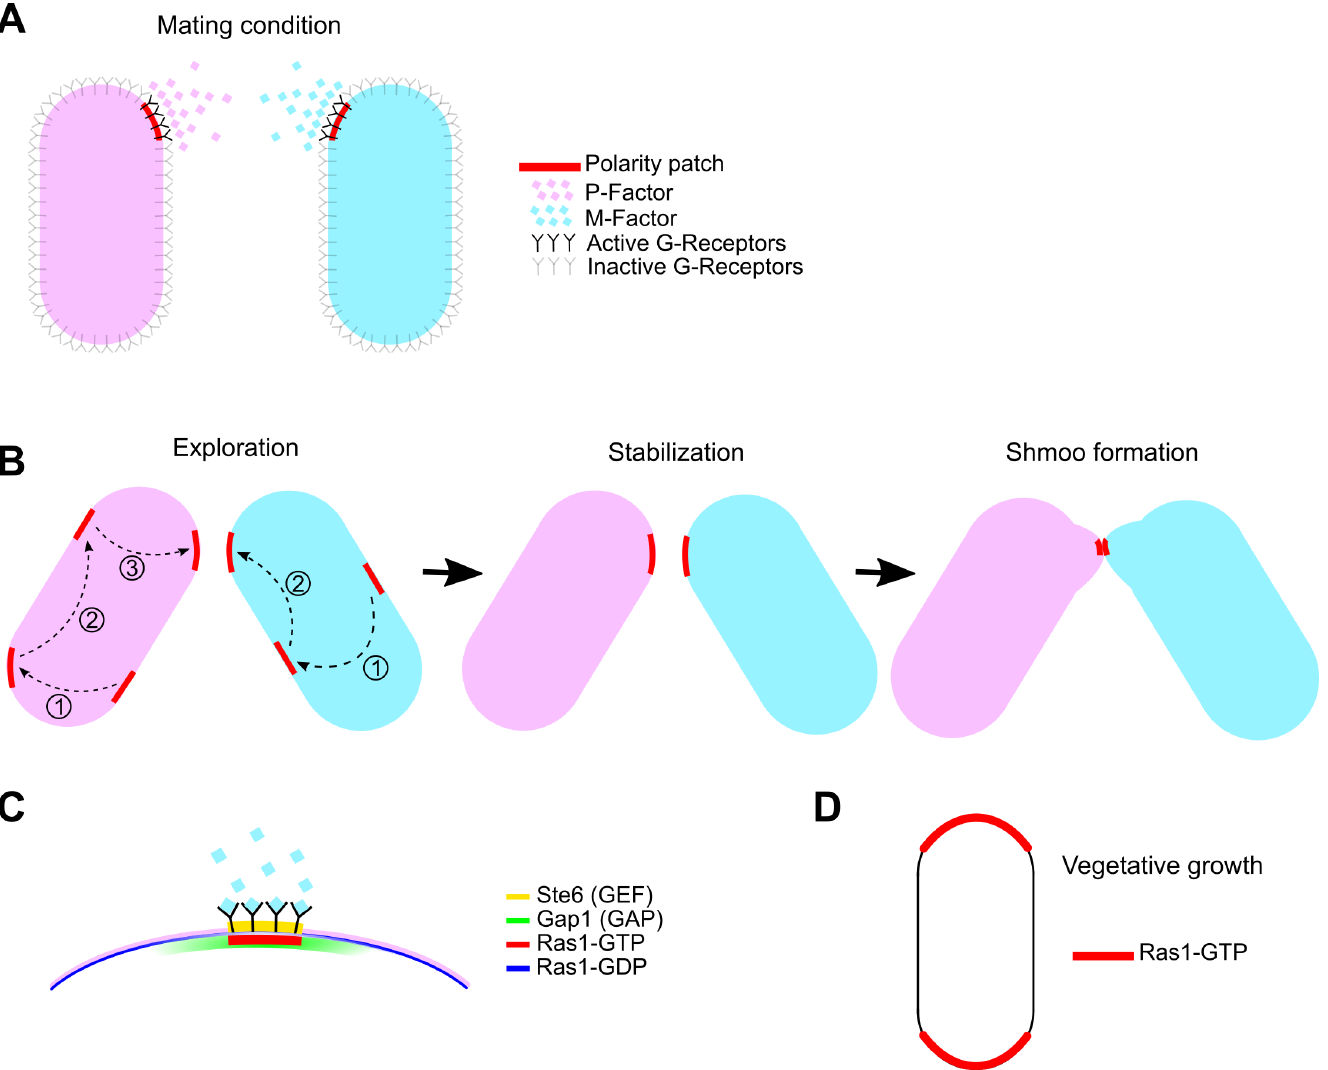
Fig 1. Schematic of fission yeast cells pheromone signaling and polarization. (A) When fission yeast cells undergo sexual differentiation, two opposite mating types P-and M-cells each secrete their own specific pheromones. Both the pheromone secretion and sensing happens locally from the polarity zones. (B) The polarity patch explores the cell periphery in discrete jumps. The dashed arrows show a sequence of patch appearance and disappearance. After few rounds of exploration it stabilizes close to the position with highest pheromone concentration from the partner. Then they grow a mating projection (shmoo) toward each other. Upon cell wall-cell wall contact the two cells fuse together. (C) The underlying signaling pathway of polarity patch formation. Upon binding of the pheromones to their cognate receptors on the surface of opposite mating type cells the MAPK pathway gets activated which in turn regulates the expression of Ste6, the GEF for Ras1. Ras1-GTP recruits its own GAP, Gap1, on the membrane. Gap1 localization is broader than Ras1-GTP. (D) Ras1-GTP localizes at the tips during vegetative growth (red) while Ras1-GDP extends across the sides.